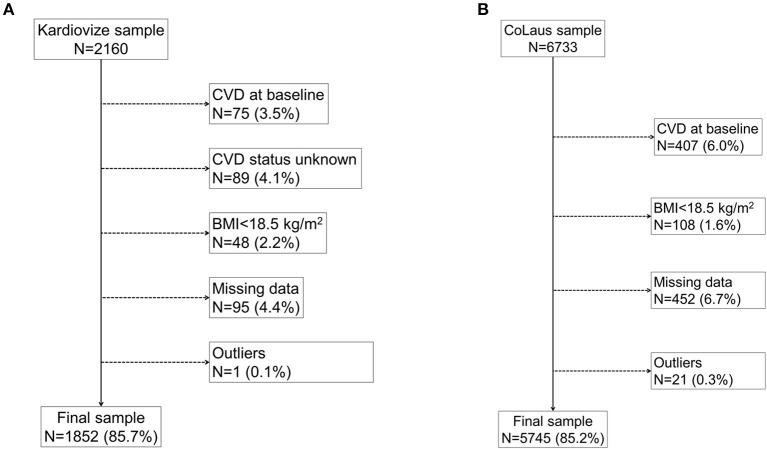
Fluxogram of participants' inclusion in the current analysis. The fluxogram displays the flow of participants and reasons for exclusion in the current analysis for the Kardiovize (A) and Colaus (B) cohorts.